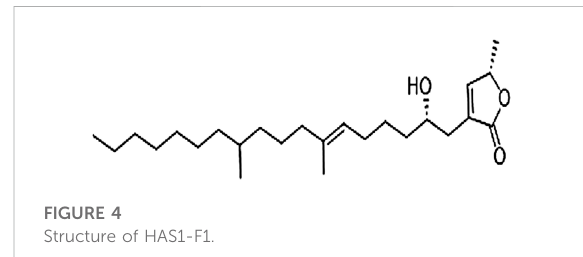
FIGURE 4 Structure of